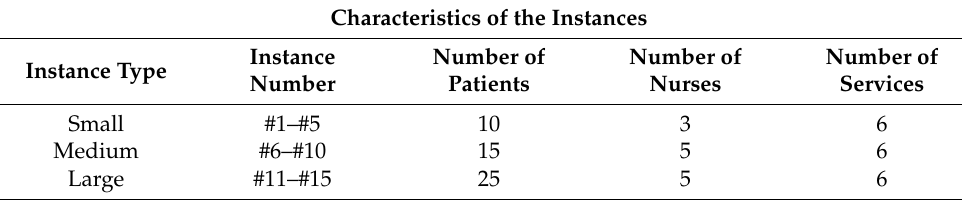
Table 3. Characteristics of the benchmark instances.